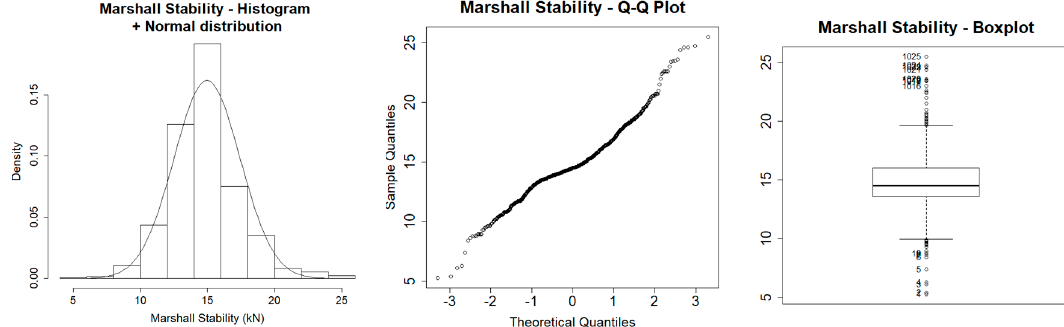
Figure 5. Normality tests applied on the stability property.